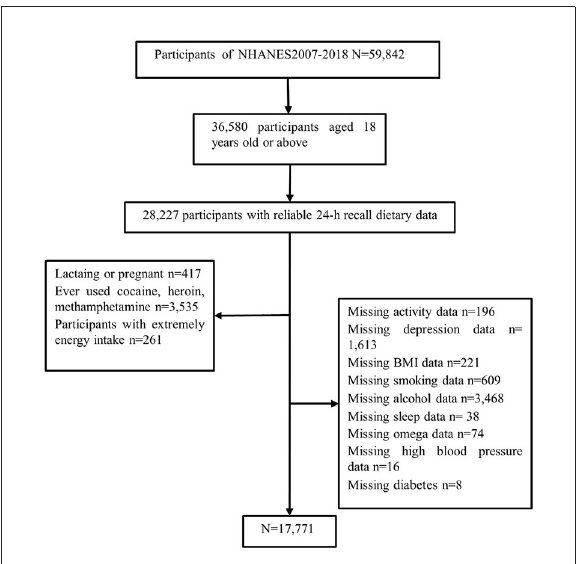
FIGURE1 Flow chart of the screening process for the selection of eligible